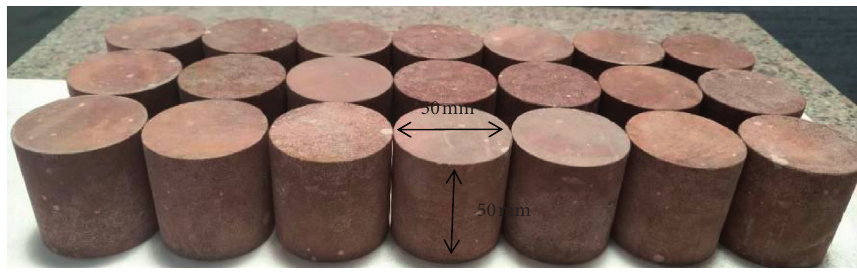
Figure 1: Sandstone samples for experiments. Table 1: Physical-mechanical properties of the sandstone (note: E is the elastic modulus; ρ and μ are, respectively, density and Poisson ratio; σ c and σ t are uniaxial compressive and tensile strength,